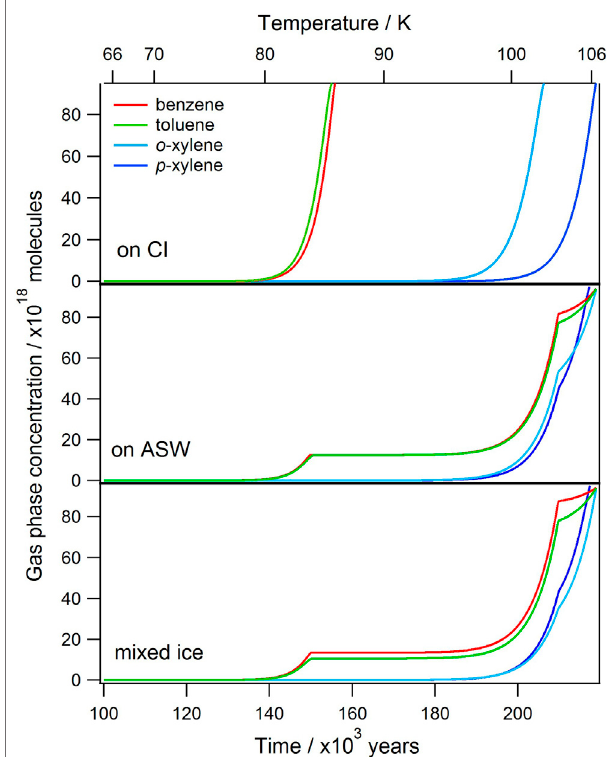
FIGURE 6 | Gas phase concentration pro fi les for 1% of benzene, toluene, o -xylene and p -xylene in different water ice con fi gurations, using astrophysical timescales for a 5 M ◉ star. The top panel shows the data from a layered CI ice, the middle panel from a layered ASW ice, and the bottom from a mixed ASW